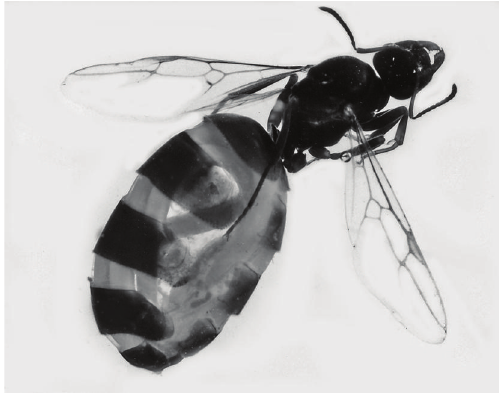
Figure 8: Pheromermis villosa in a carpenter ant from Holland.